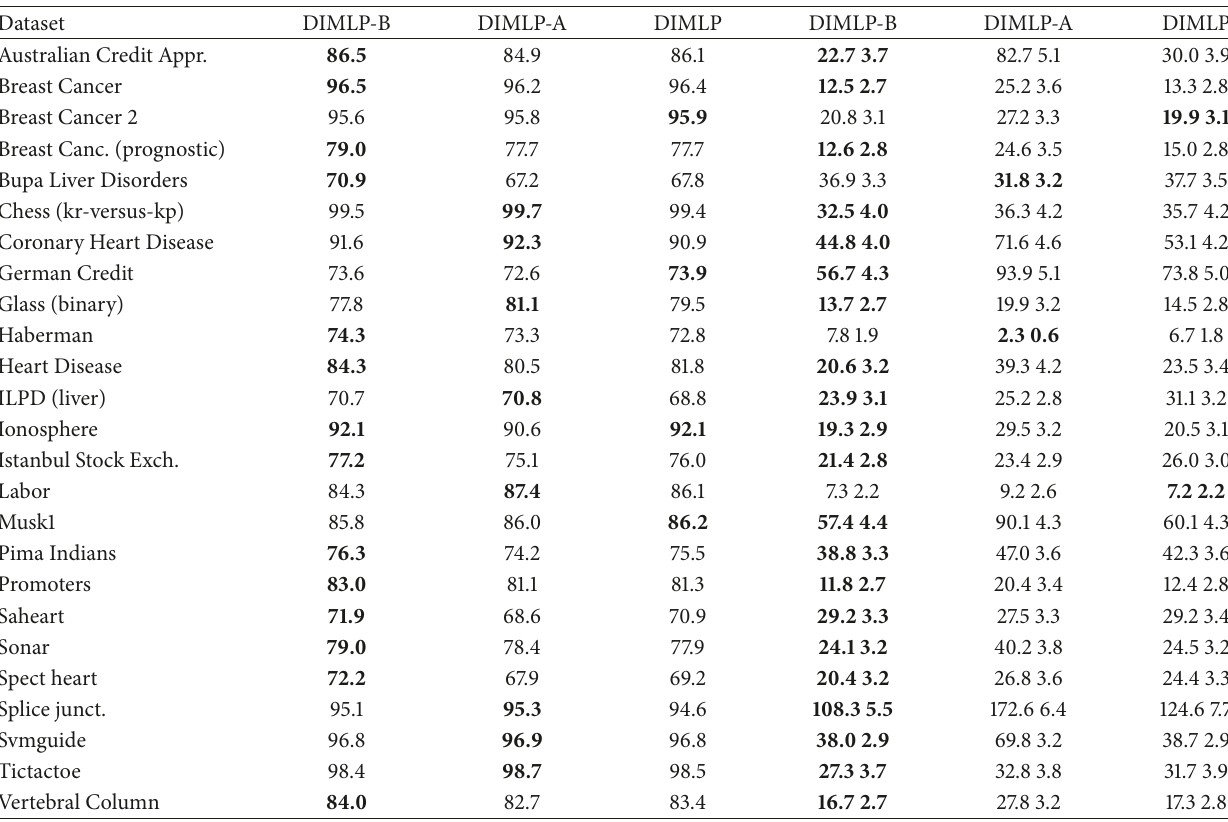
Table 10: Average predictive accuracy of extracted rulesets from DIMLP-Bs, DIMLP-As, and single DIMLPs (columns 2, 3, and 4). Average complexity of rulesets (last three columns).